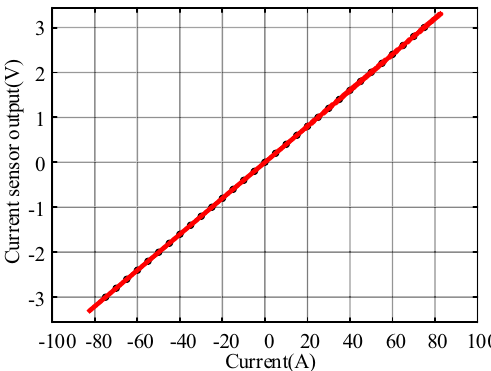
Figure 9. I – V characteristic of the current